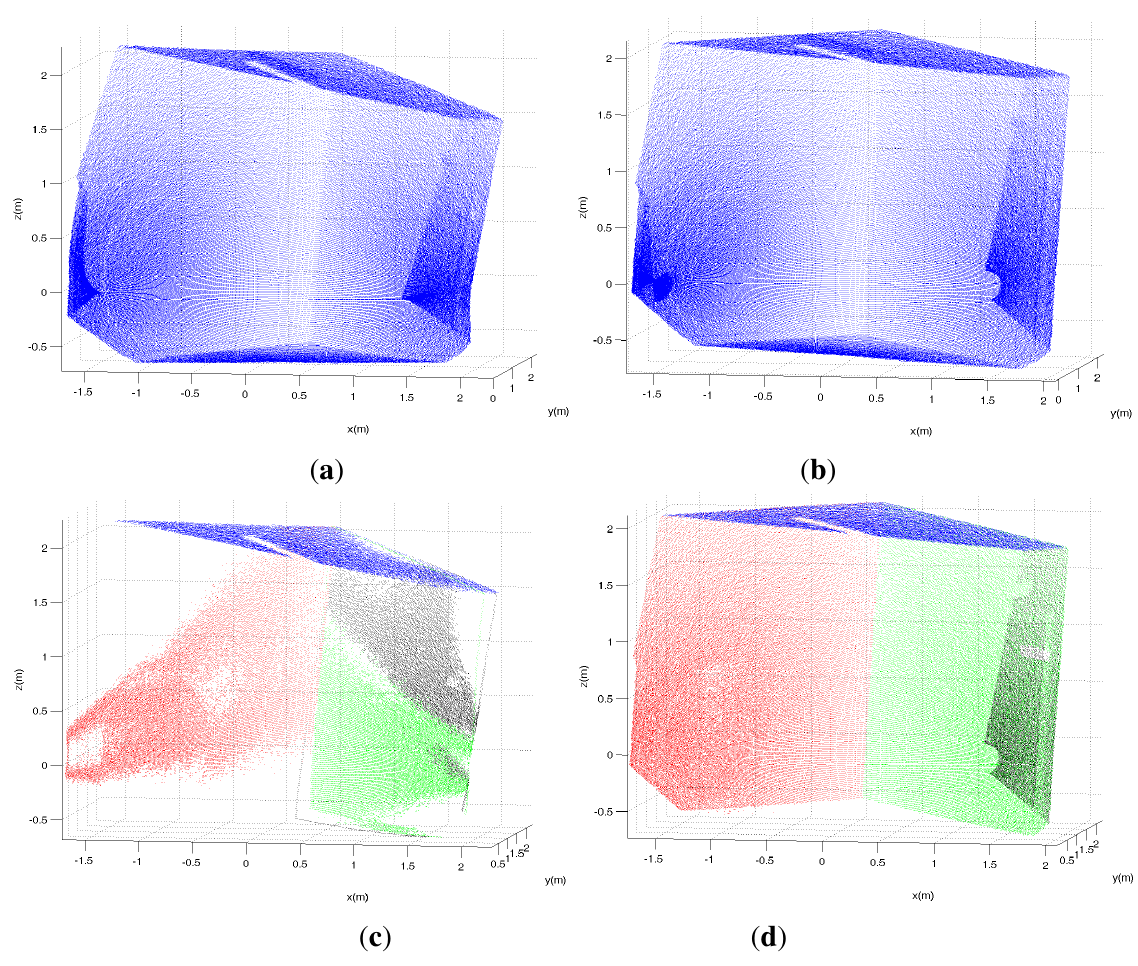
Figure 9. The point cloud obtained by the first unit with a a = 0 ◦ , g = 5 . 78 ◦ misalignment before ( a ) and after ( b ) calibration with P = 4 . The inliers in detected planar patches are shown in red, blue, green and black before ( c ) and after ( d )